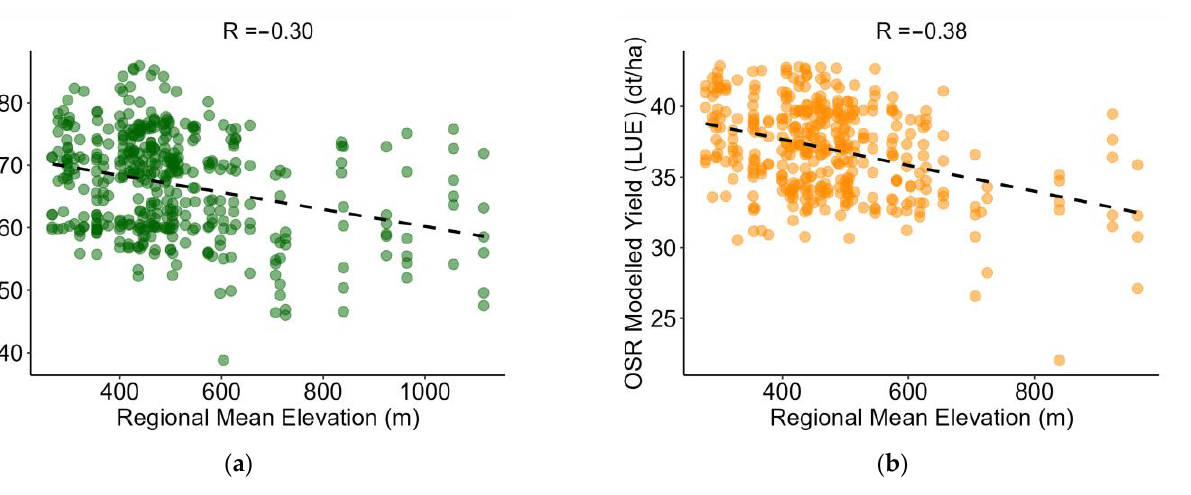
Figure 7. The scatter plots compare the accuracies of the modelled and referenced yields (at a 95% confidence interval) of ( a ) WW and ( b ) OSR for 19 years together (i.e., from 2001 to 2019). The values of the statistical parameters such as R 2 , RMSE (dt/ha), ME (dt/ha), and total number of points (n) are displayed at the top of each plot. Every plot contains a solid line (1:1 line) that is used to visualise the correlation of pixels between the modelled and referenced yield values. The dashed line represents the regression line. Different colours of the points display different years.